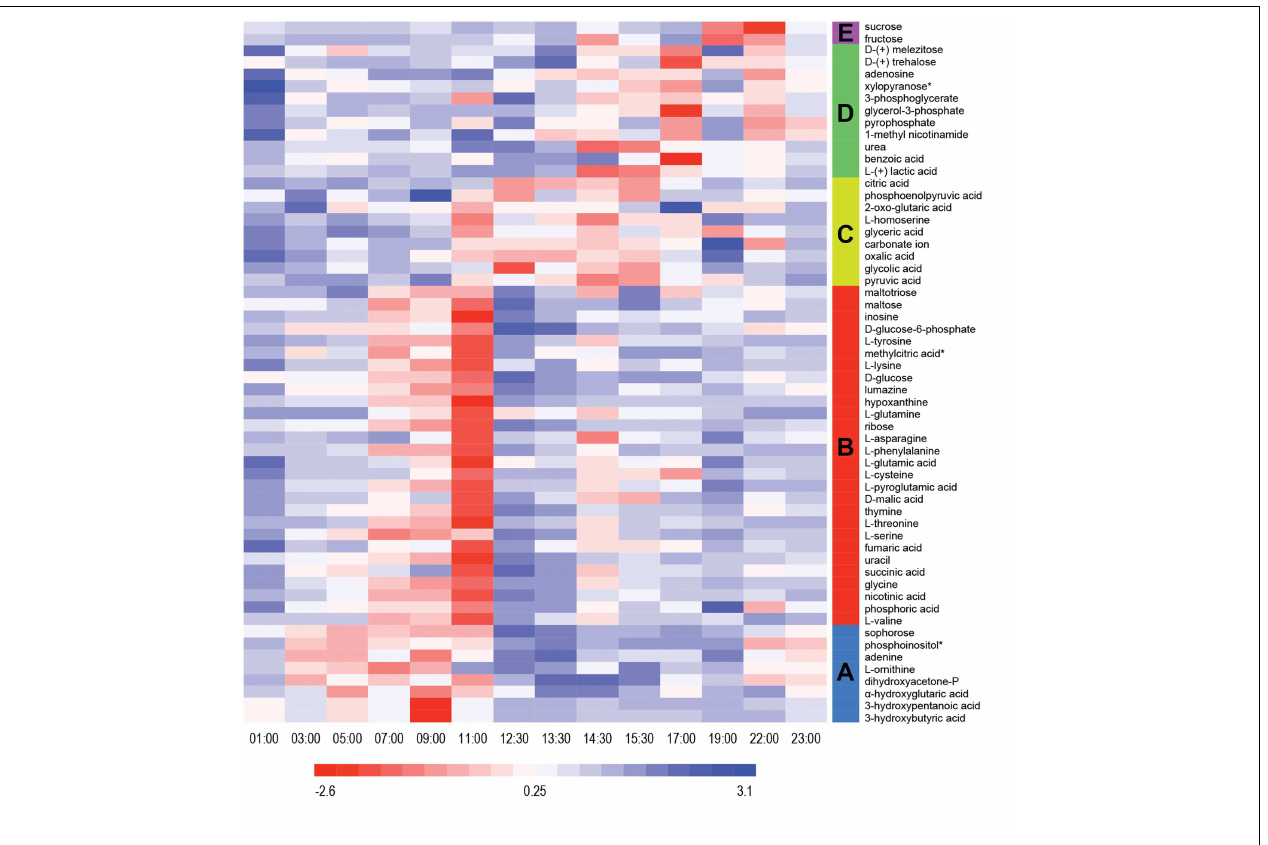
FIGURE 2 | Heat map view of z-scored polar metabolite abundances over a diel cycle. A total of 58 metabolites were reproducibly detected ( n = 3 ) and confidently identified in the mat samples. The scale bar indicates the z-score transformed average intensity values of metabolites. K-means